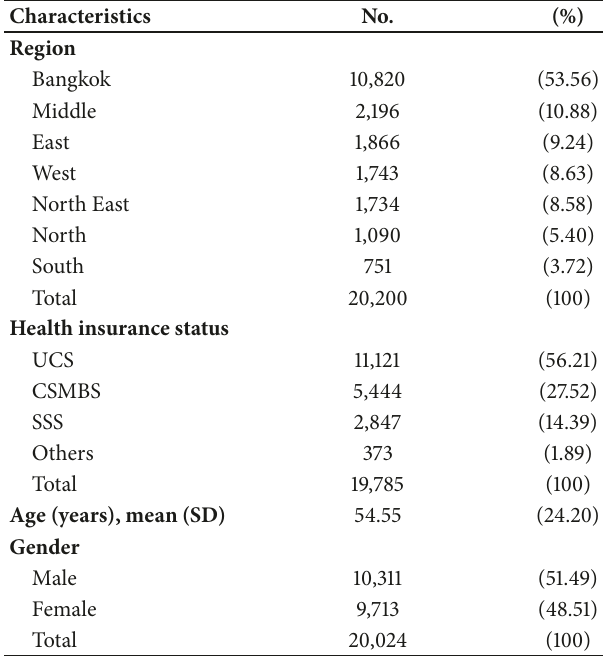
Table 1: Summary of patient demographics requested for